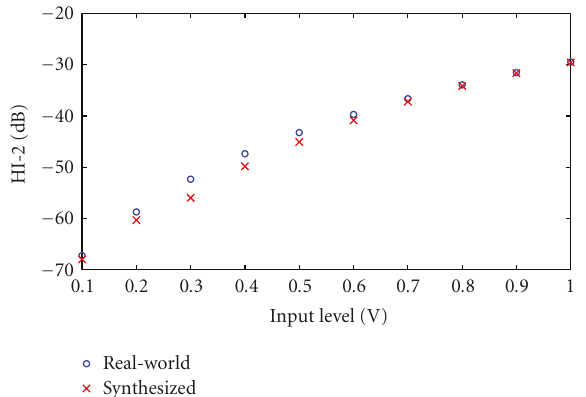
Figure 11: HI-2 of synthesized and real-world signals as a function of the input level (pedal 2).